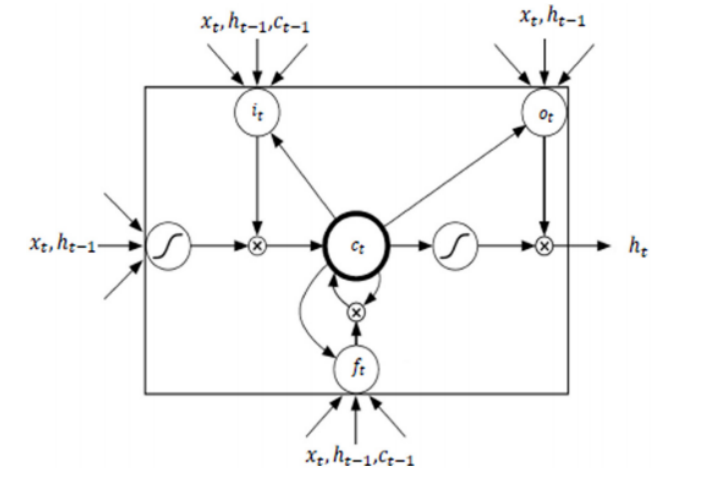
Figure 5. LSTM CELL based on